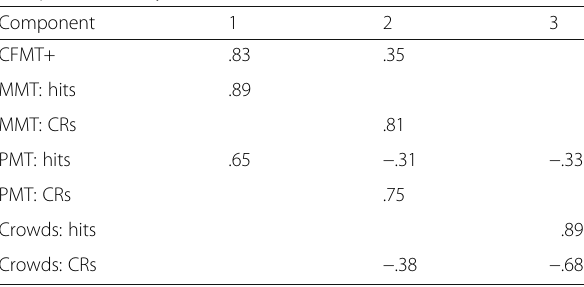
Table 7 Factor loadings for combined performance of the control and experimental groups, based on principal components analysis with oblimin rotation